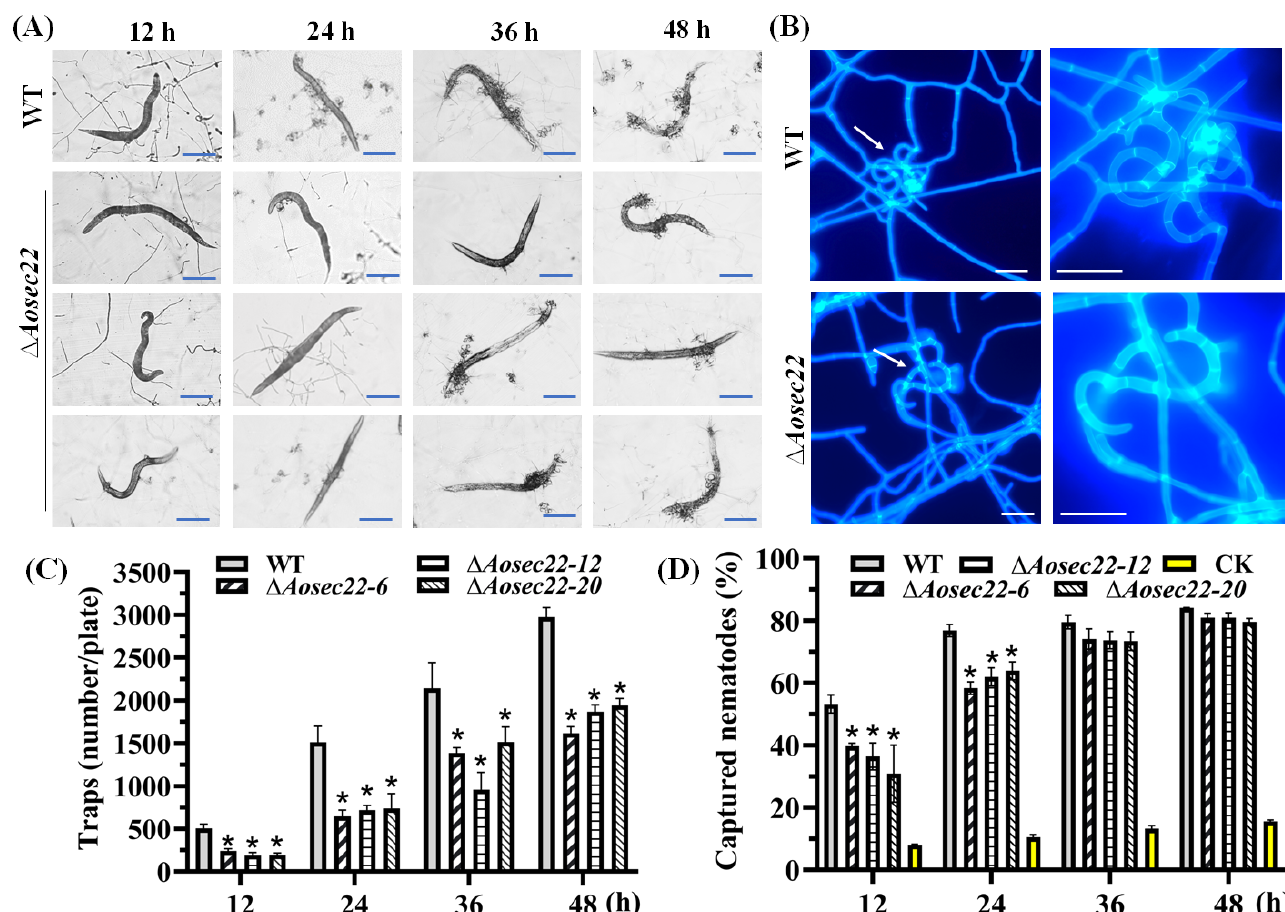
Figure 3. Role of AoSec22 in trap formation, nematocidal activity, and trap morphology. ( A , B ) Microscopic images for trap formation and nematode predation at different time points and enlarged traps at 48 h. White arrows: traps. Bar: 100 µm in ( A ) and 10 µm in ( B ). ( C ) Counts of traps produced by WT and ∆ Aosec22 mutant strains at 12, 24, 36, and 48 h. ( D ) Percentages of nematodes captured by WT and ∆ Aosec22 mutant strains at 12, 24, 36, and 48 h. An asterisk ( C , D ) indicates a significant difference between the ∆ Aosec22 mutant and the WT strain (Tukey’s HSD, p < 0.05).